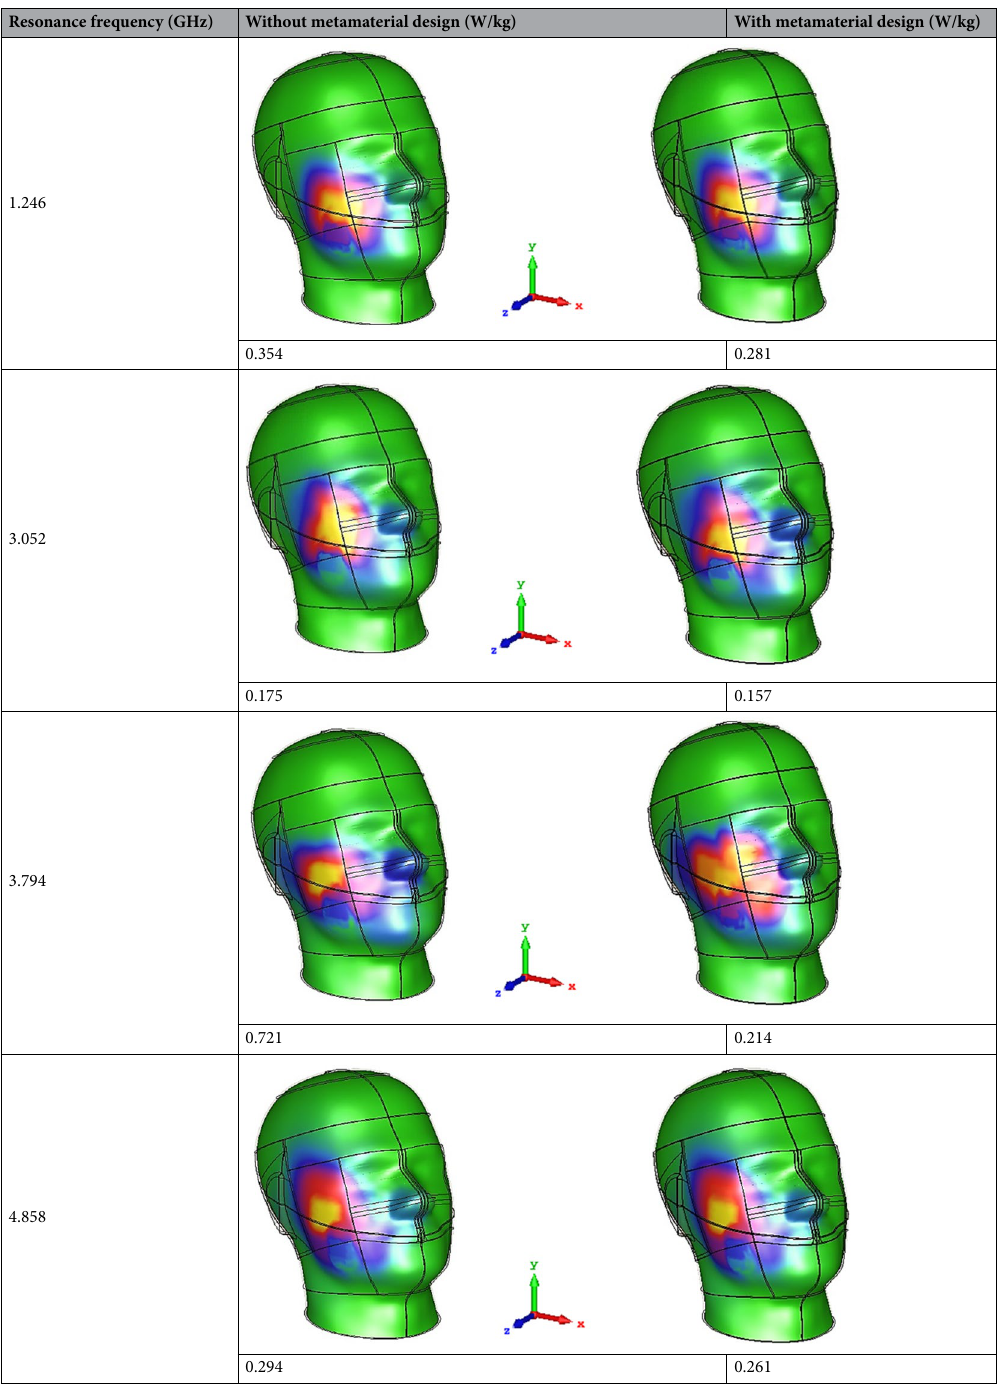
Table 6. SAR reduction values of 10 g of tissue volume with and without proposed metamaterial